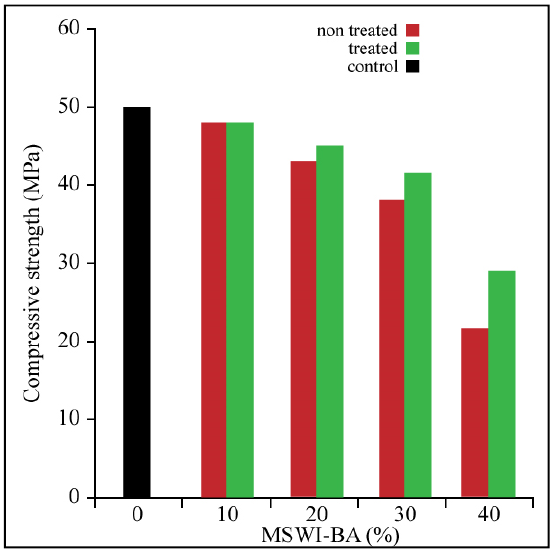
Figure 5. Effect of the chemical treatment of MSWI-BA on the compressive strength of concrete at 28 days, redrawn from [37].